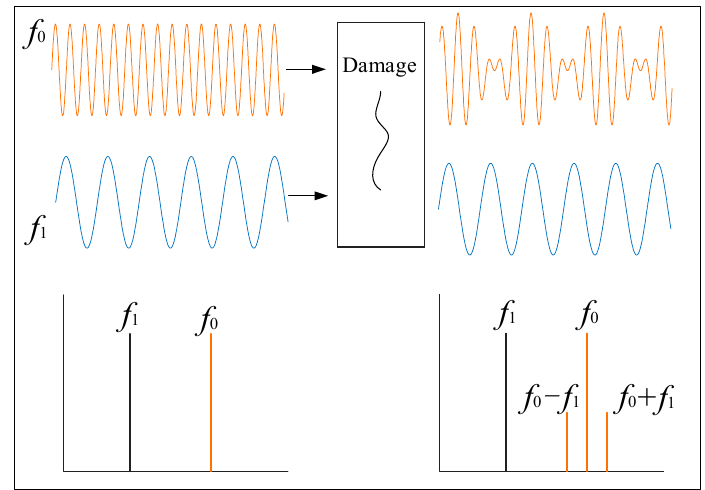
Figure 1. Principle of vibro-acoustic modulation (VAM) technique.